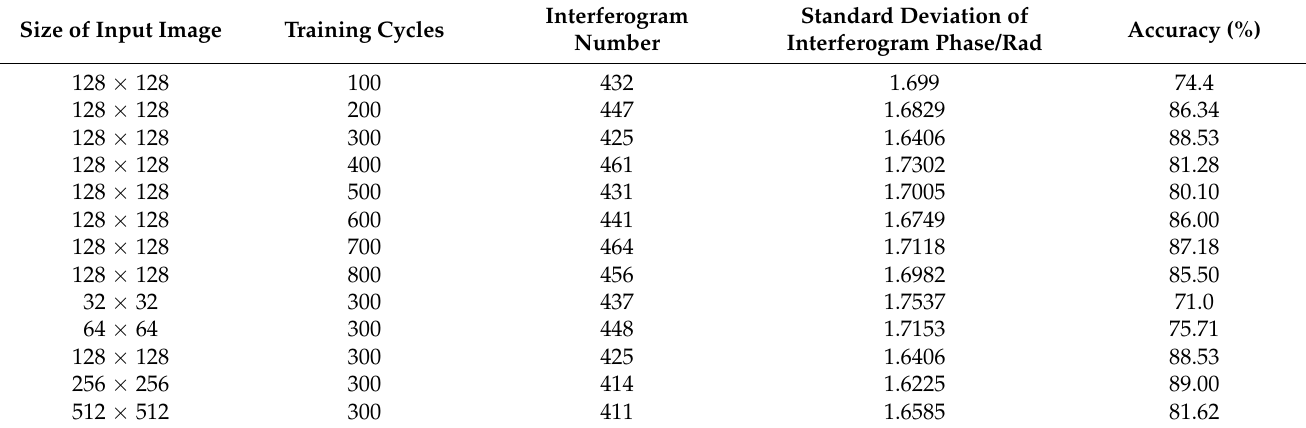
Table 2. Setting of training parameters and results of the Resnet50